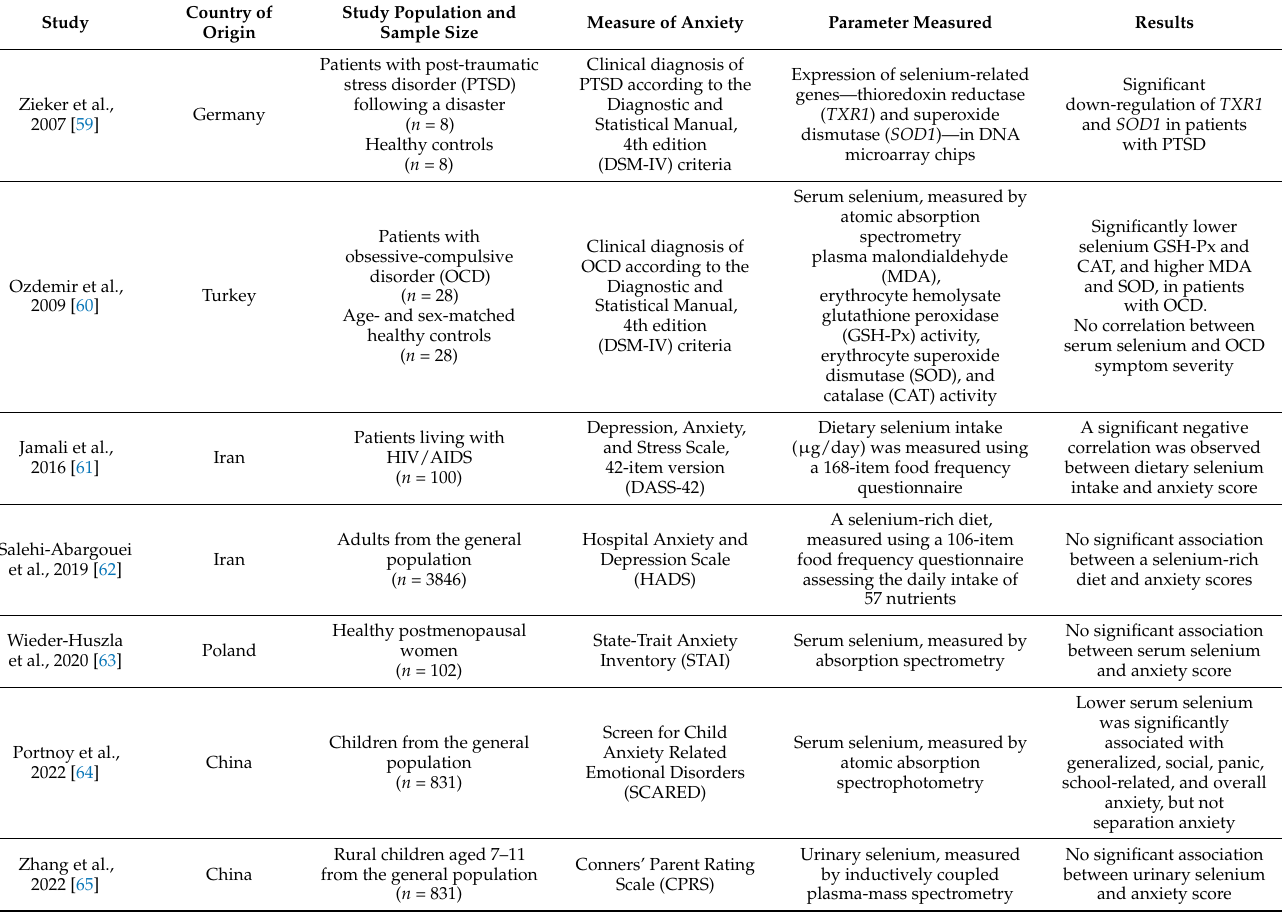
Table 2. Observational studies of selenium or selenium-related biomarkers in relation to anxiety in